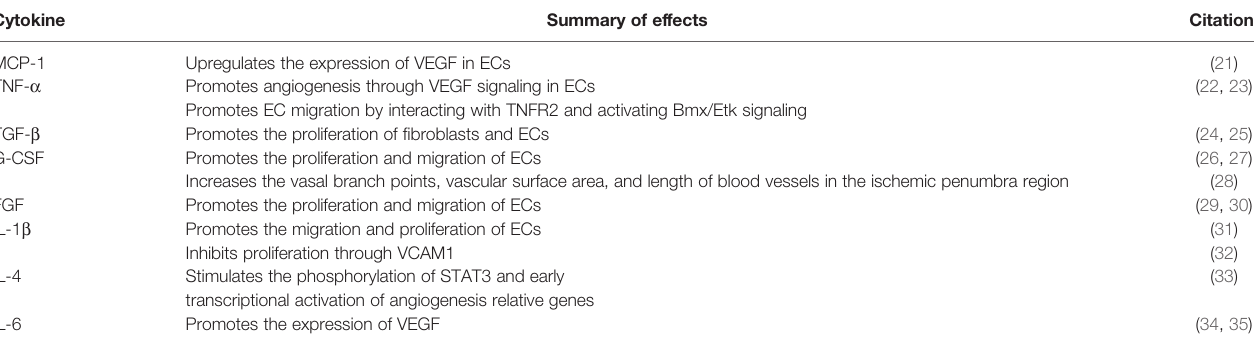
TABLE 1 | The role of pro-in fl ammatory cytokines in angiogenesis after stroke.